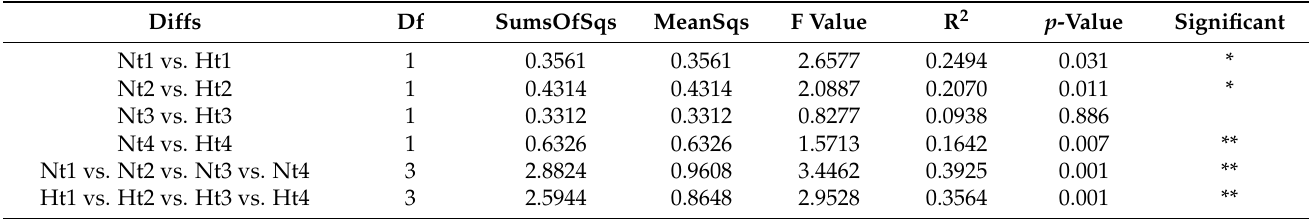
Figure 3. Beta diversity of G. vermiculophylla -associated epimicrobiota at two different temperatures. A principal coordinate analysis (PCoA) plot of G. vermiculophylla associated epimicrobiota based on Bray–Curtis distance. Different colors represented different months. Different dots indicate different samples. Nt: normal seawater temperature; Ht: 3 ◦ C higher temperature; 1, 2, 3, and 4 represent May, June, July, and August, respectively. Table 1. Adonis test value of PCoA analysis.